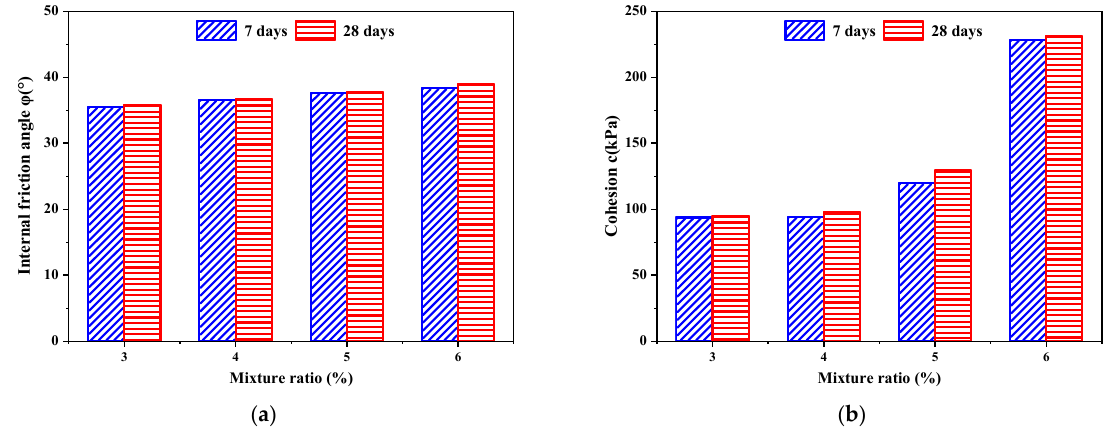
Figure 11. Shear strength parameters. ( a ) Internal friction angle φ ; ( b ) cohesion c . Under the same WPU content, the internal friction angle and cohesion of PURD both increase with curing time, but not obviously. The strength of PURD is mainly provided by the bite force and friction generated by the mutual extrusion of RA particles and the bonding force generated by the curing reaction of WPU. The increase in internal friction is mainly due to the curing reaction between WPU and water in the specimen, and the curing reaction will gradually end with the increase in curing time, resulting in the de- crease in water in the specimen. The internal friction angle will increase with the decrease and friction between RA particles [50]. Additionally, WPU itself is also prone to oxidative consolidation reaction, which will produce high-strength adhesion and can better bond loose RA particles together. Moreover, a large number of long-chain macromolecules and isocyanate groups in WPU make it have a special polymer reticular structure, which can significantly improve the cohesion of the specimen [31,32]. With the increase in curing time, the consolidation reaction between WPU and water and the oxidative consolidation reaction of WPU will proceed more completely, thereby further increasing the cohesion of PURD. 4. Mechanism Analysis Through the above UU test results and analysis, it has been found that WPU has an important effect on the mechanical properties of RA, and the variation law of the shear strength of PURD with different WPU contents has been obtained. However, the above results are analyzed from the macro-mechanical level, which has the disadvantage of rel- ative superficiality. Therefore, we can try to make an in-depth analysis of the mechanism of WPU enhancing RA from the micro-level. Therefore, the SEM test was performed on PURD with different WPU contents, and the SEM images at 500 times and 2000 times magnification were taken, respectively (see Figure 12).